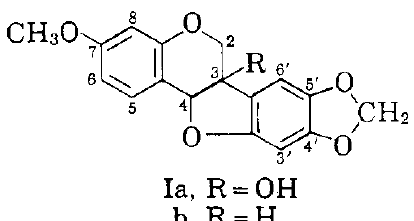
Figure 2. The structural formula of pisatin [33]. Structural formula derived from Perrin, D. R. and Bottomley W., Studies on phytoalexins. V. The structure of pisatin from Pisum sativum L. Australian J. Biol. Sci.1962 14 : 336-340 [33].